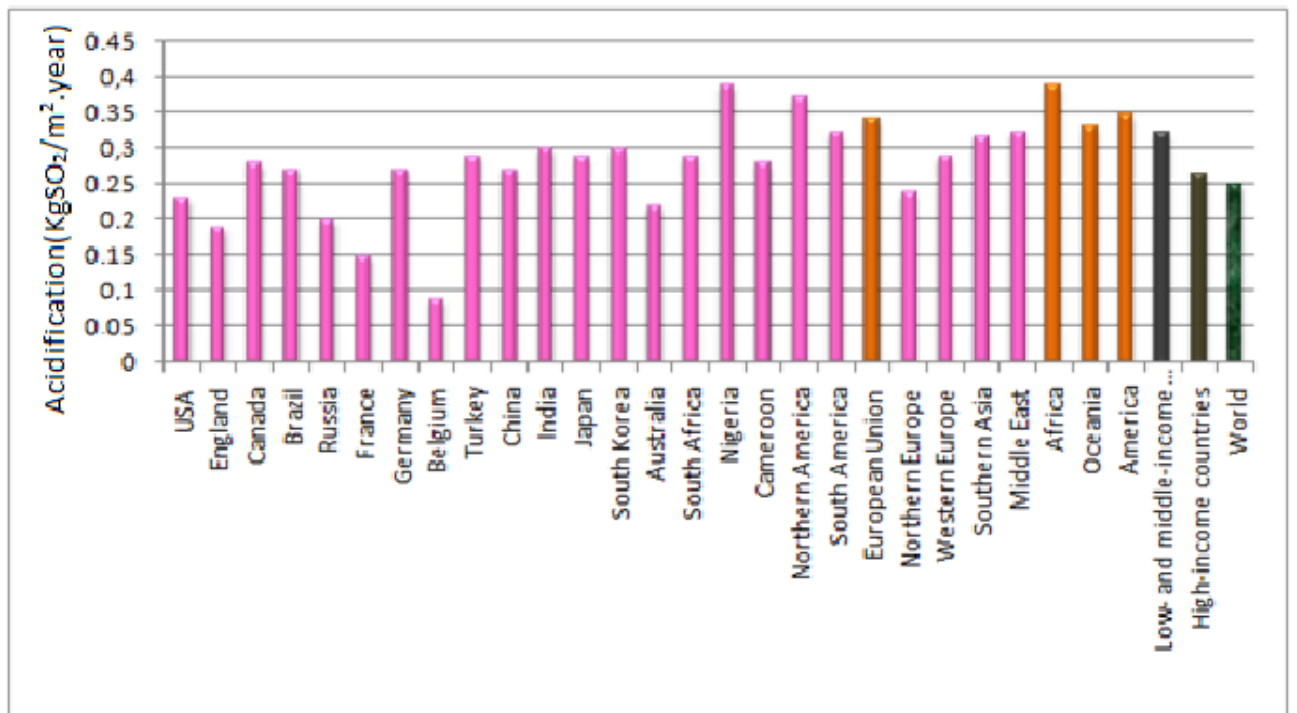
Figure 3. Assessment of acidification quantity per square meter coming from a sustainable neighborhood distributed in some countries, regions and continents in the world